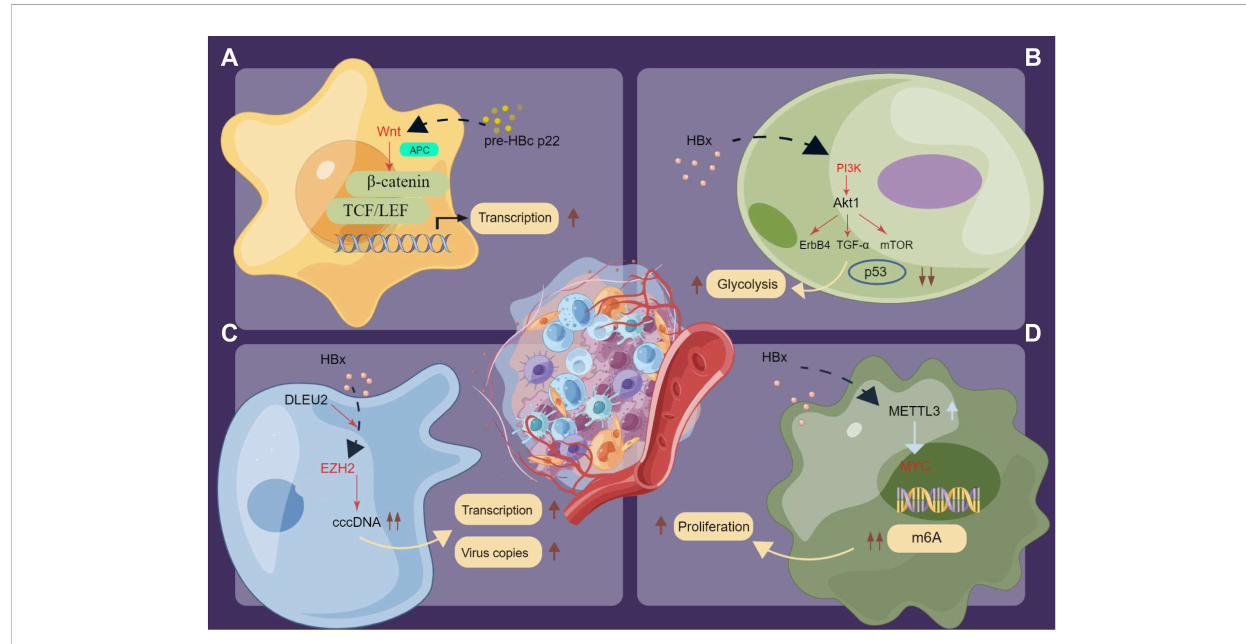
FIGURE 4 The potential signaling pathways in inducing extrahepatic cancers under the chronic HBV infection. (A) HBV p22 elevates TCF/ b -catenin transcription in cancer cells owing to mutations in downstream genes of the Wnt pathway. (B) HBx activates the PI3K/Akt signaling pathway and promotes glucose metabolic reprogramming in extrahepatic cancers. (C) HBx enhances the transcription and induces the accumulation of DLEU2 in infected hepatocytes. The co-recruitment HBx protein and DLEU2 could elevate the expression levels of EZH2 as well as the levels of viral cccDNA and further boost transcription and viral replication in the host. (D) HBx increases the expression level of oncogenes like MYC and the N6- methyladenosine (m6A) modi fi cation of MYC mRNA to promote the proliferation of cancer cells. Pre-HBc p22, pre-hepatitis B core protein 22; HBx, Hepatitis B virus X protein; TCF/LEF, T-cell Factor/Lymphoid Enhancing Factor; TGF- a , Transforming Growth Factor a ; cccDNA, covalently closed circular DNA; DLEU2, deleted in lymphocytic leukemia 2; EZH2, zeste homolog 2; MYC, myelocytomatosis oncogene; m6A,